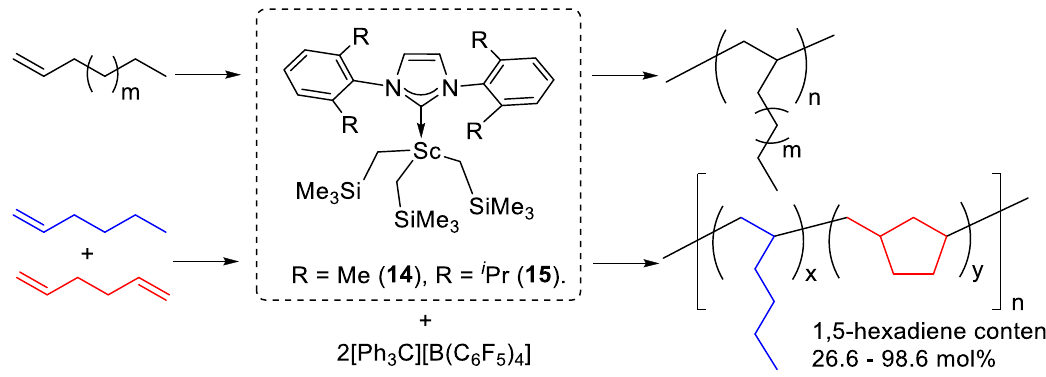
Figure 3. Trialkyl Sc complexes bearing an NHC used for α -olefin (co-)polymerization.